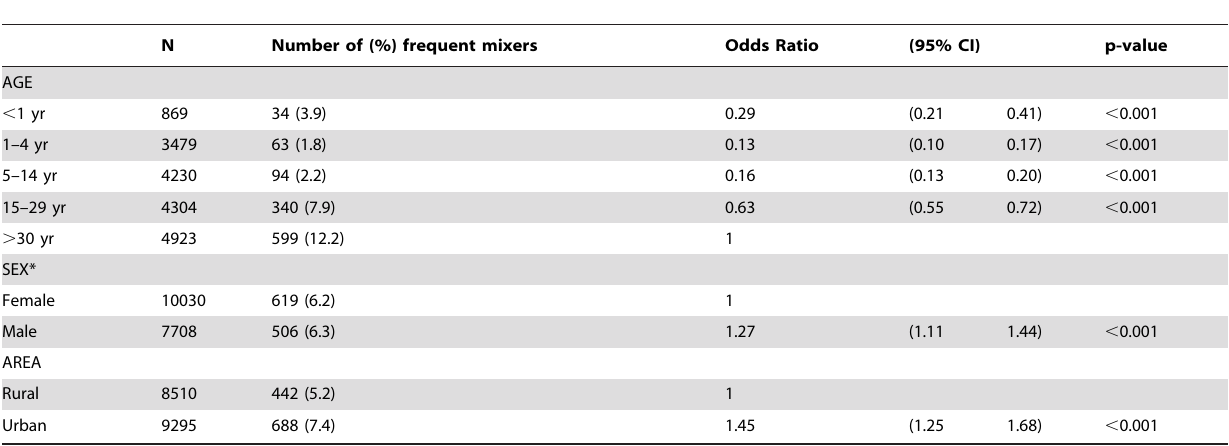
Table 3. Multivariable analysis comparing frequent mixers to all others by age, sex and area.